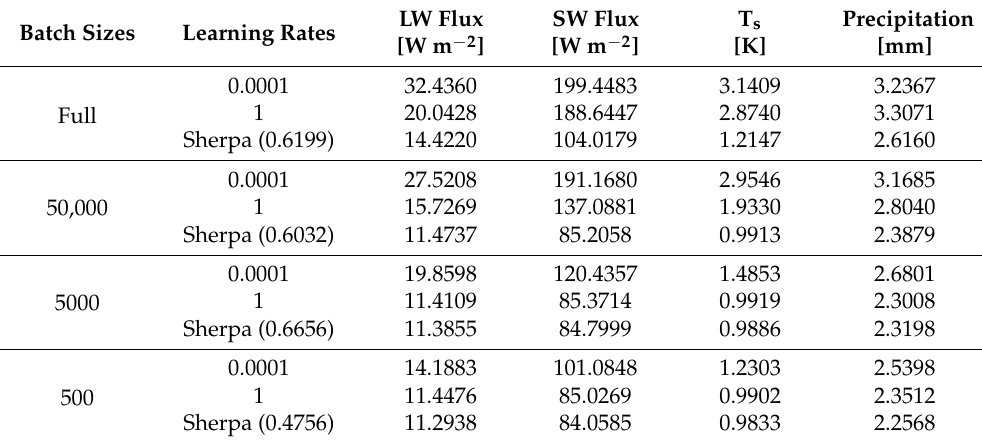
Table 1. The evaluation results of root mean square errors (RMSEs) for LW flux, SW flux, skin temperature (T s ), and 3-hourly accumulated precipitation. The July period in 2020 and entire spatial domain were used for